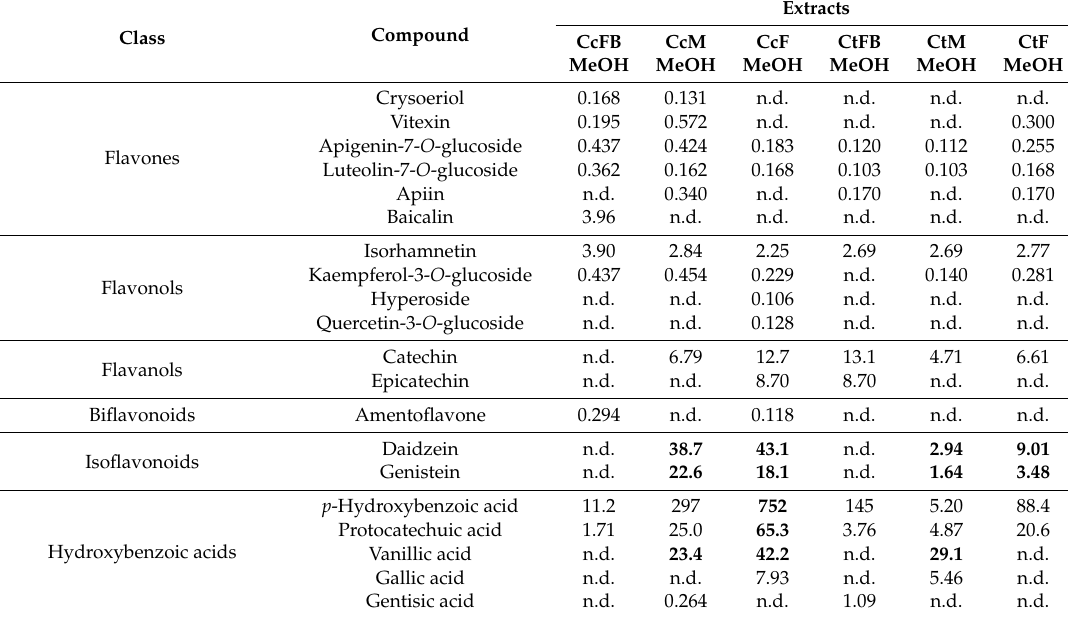
Table 2. The content of phenolic compounds in the analysed samples ( µ g /